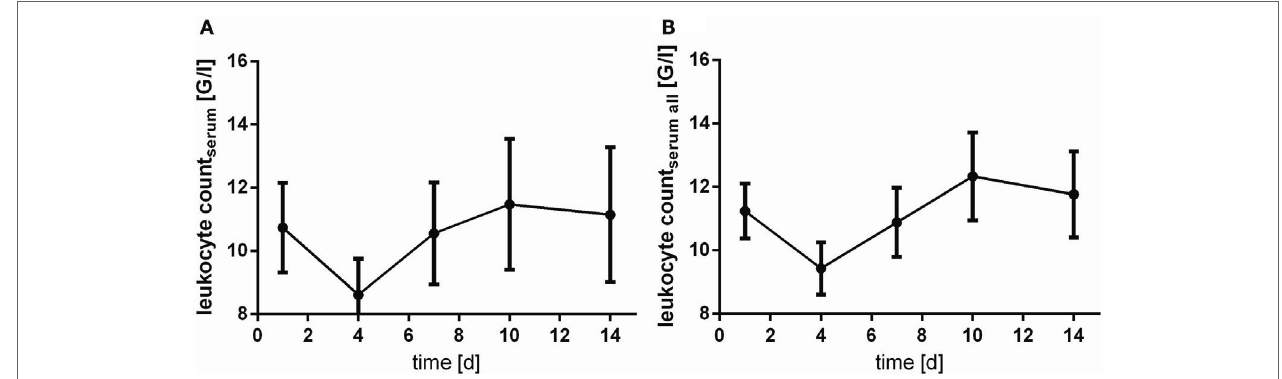
FigUre 6 | Time courses of leukocyte count in serum samples of the patients with cerebrospinal fluid samples [ (a) ; leukocyte countserum] and all serum samples available [ (B) ; leukocyte countserum all] and their 95% confidence interval are displayed. Differences between nadir and peak values assessed via Wilcoxon Rank Test: leukocyte count: day 4 vs. day 10: p < 0.0001.